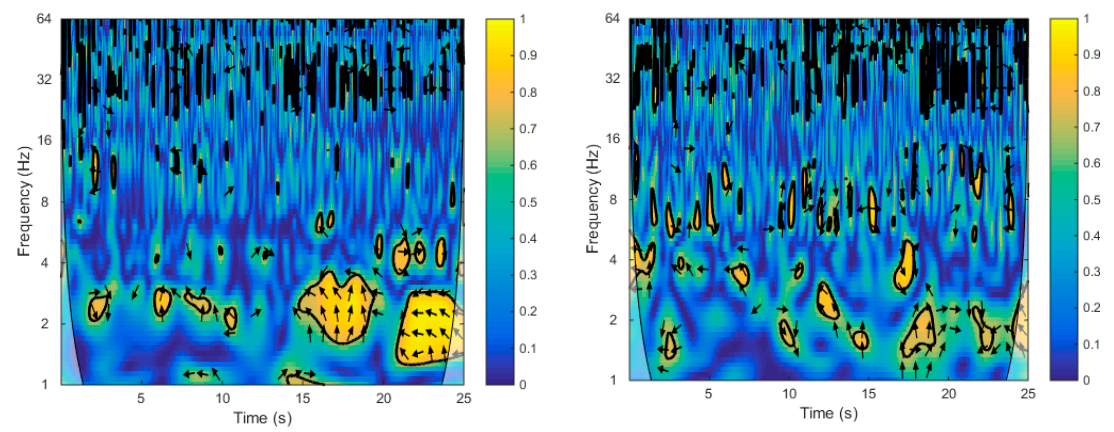
Figure 12. Wavelet coherence between the main span’s signals and the car body’s signals: ( a ) vertical acceleration signals ( b ) transverse acceleration signals.